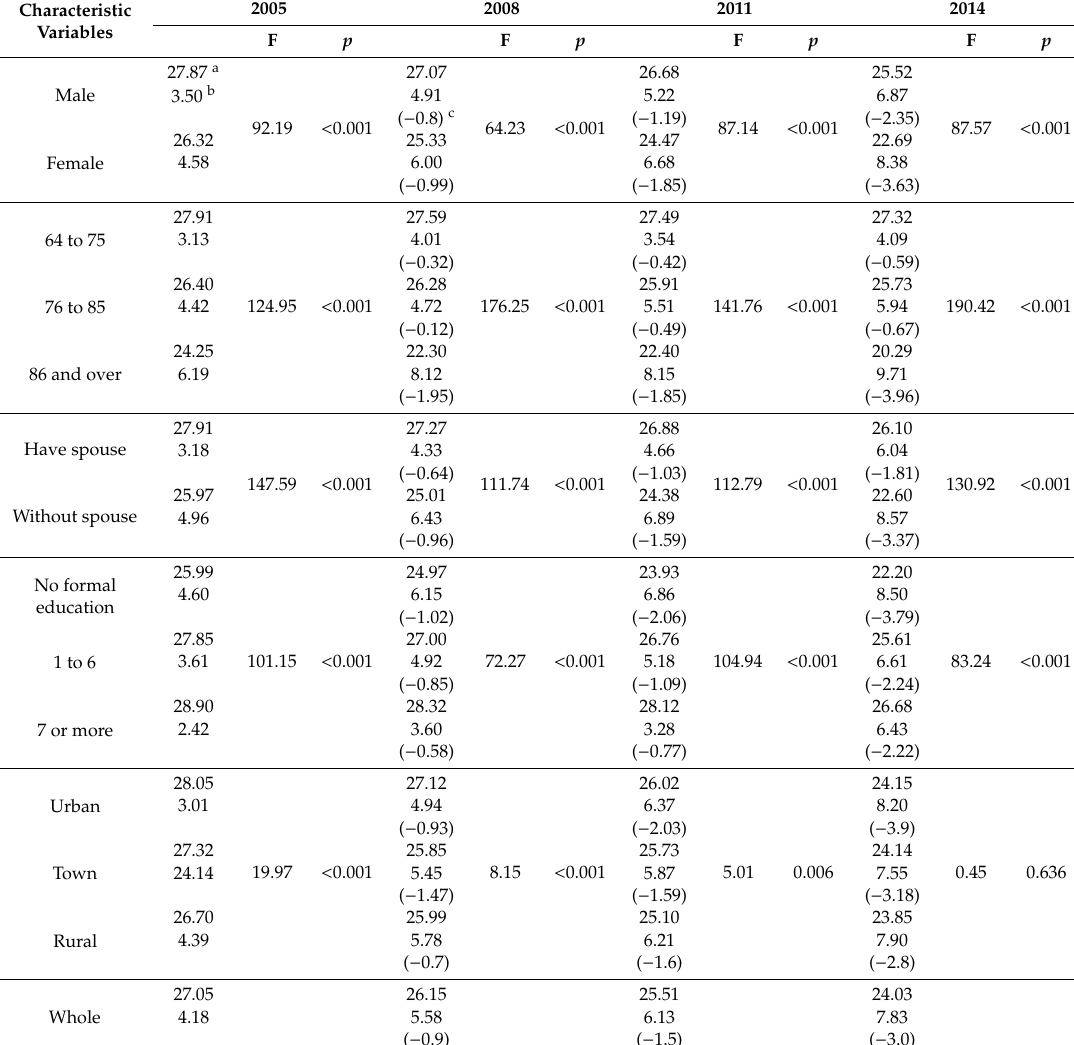
Table 4. Cognitive function of di ff erent groups from